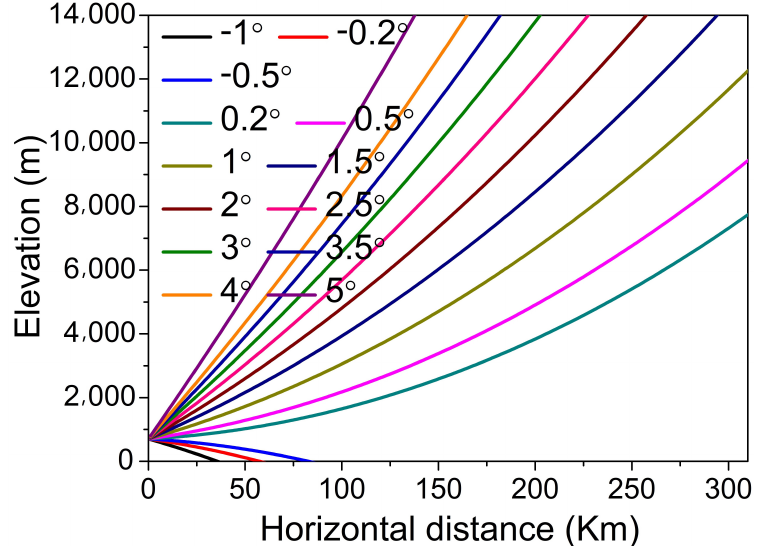
Figure 5. Modified propagation paths of radio with the modified